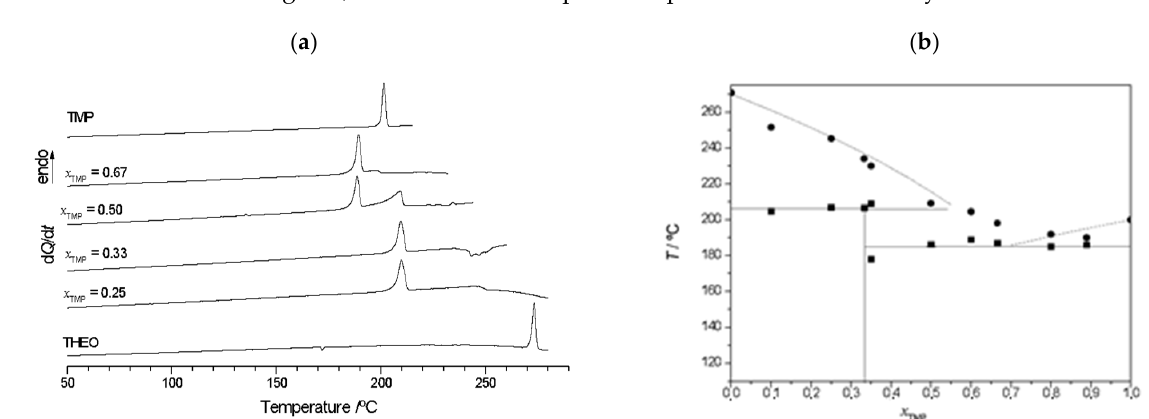
Figure 9. ( a ) Representative DSC heating curves of TMP + THEO mixtures of different TMP mole fractions, x TMP , prepared by LAG, ethanol-assisted. β = 10 °C/min −1 . ( b ) (Solid + liquid) binary phase diagram of TMP + THEO ■ and solid horizontal line—experimental solidus; ● —experimental liquidus; vertical line—co-crystal composition. Dotted lines obtained using eq. (1).